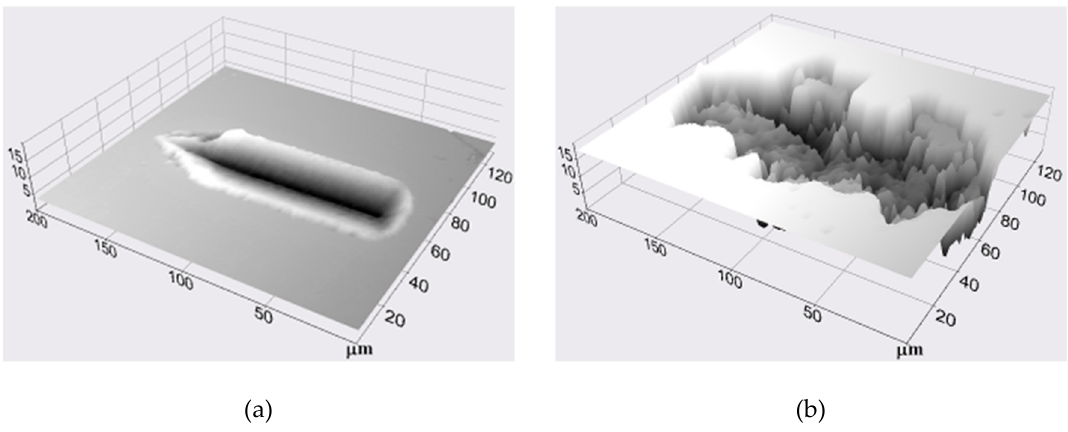
Figure 11. Scratch profile on the float glass surface in the air ( a ) and in the water ( b ).